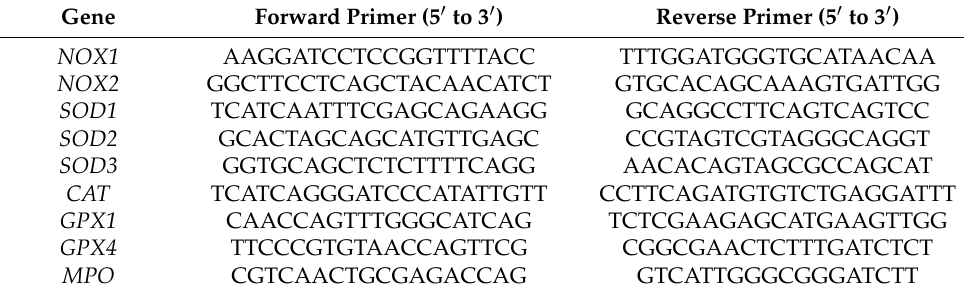
Table 1. Primer sequences used for